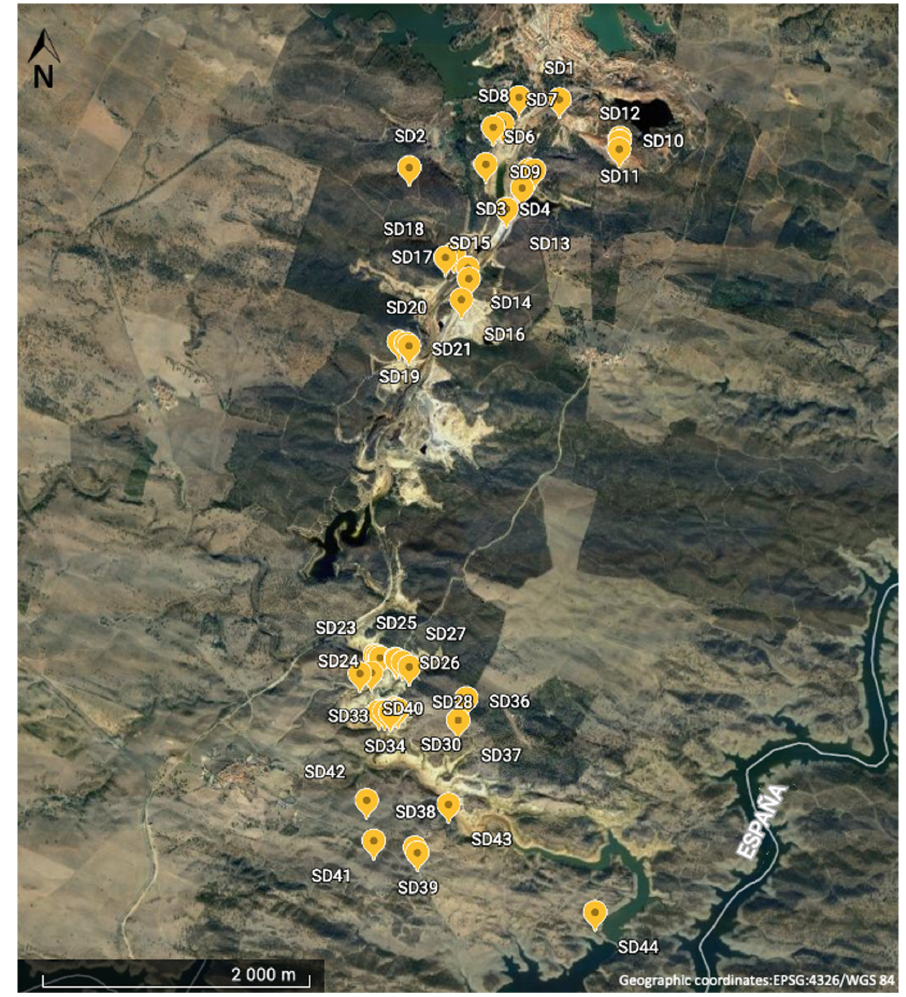
Figure 4. Google Earth image (24 May 2022) evidencing the sampling sites at the São